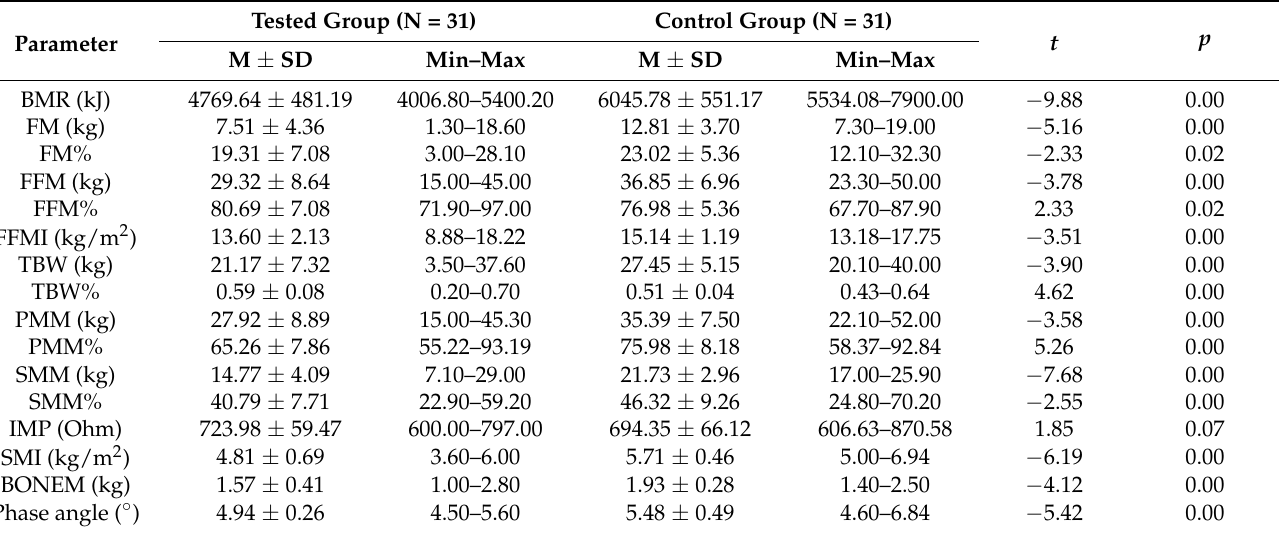
Table 3. Descriptive characteristics of total body composition parameters and statistical